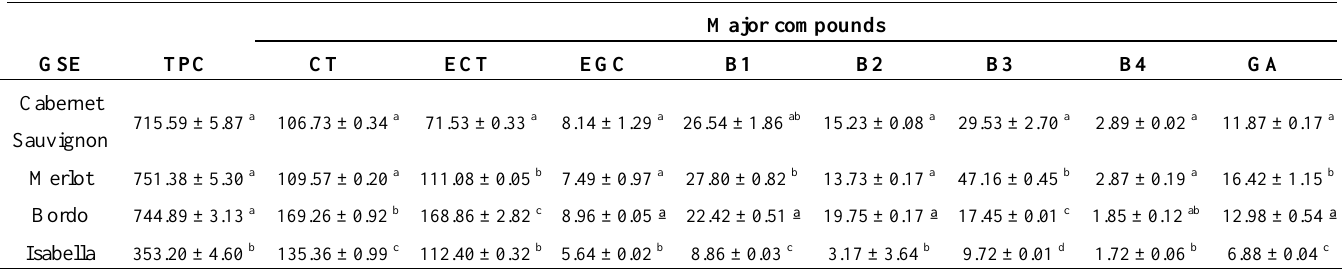
Table 1. Total polyphenol content (mg/L equivalent of catechin) and major compounds (mg/L) in the wine waste extracts.